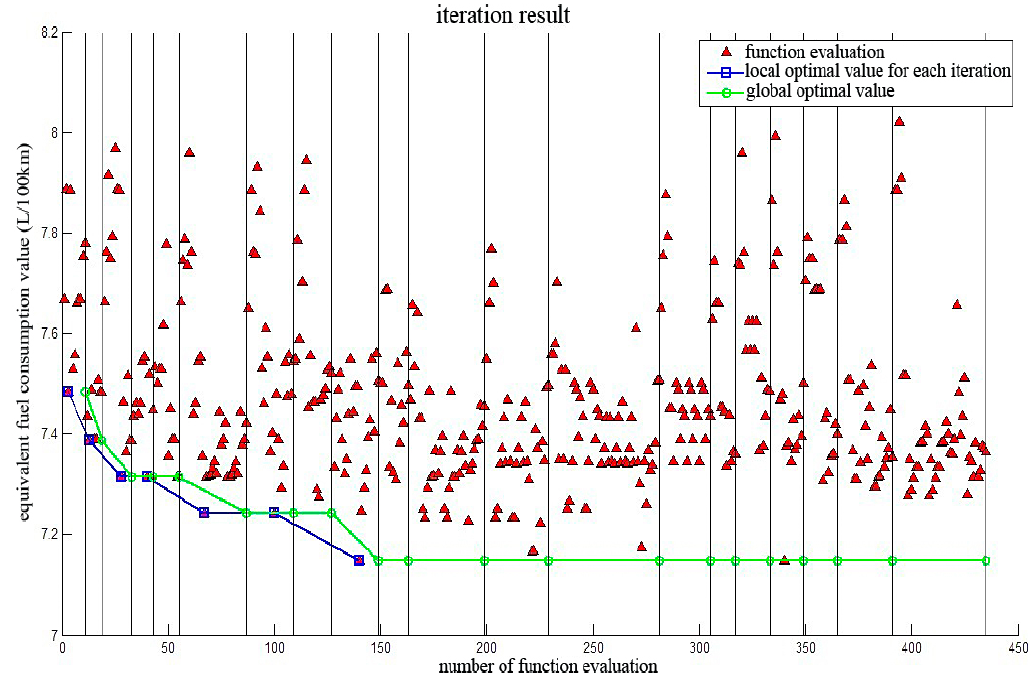
Figure 21. Equivalent fuel consumption per 100 km with different function evaluations using DIRECT algorithm.